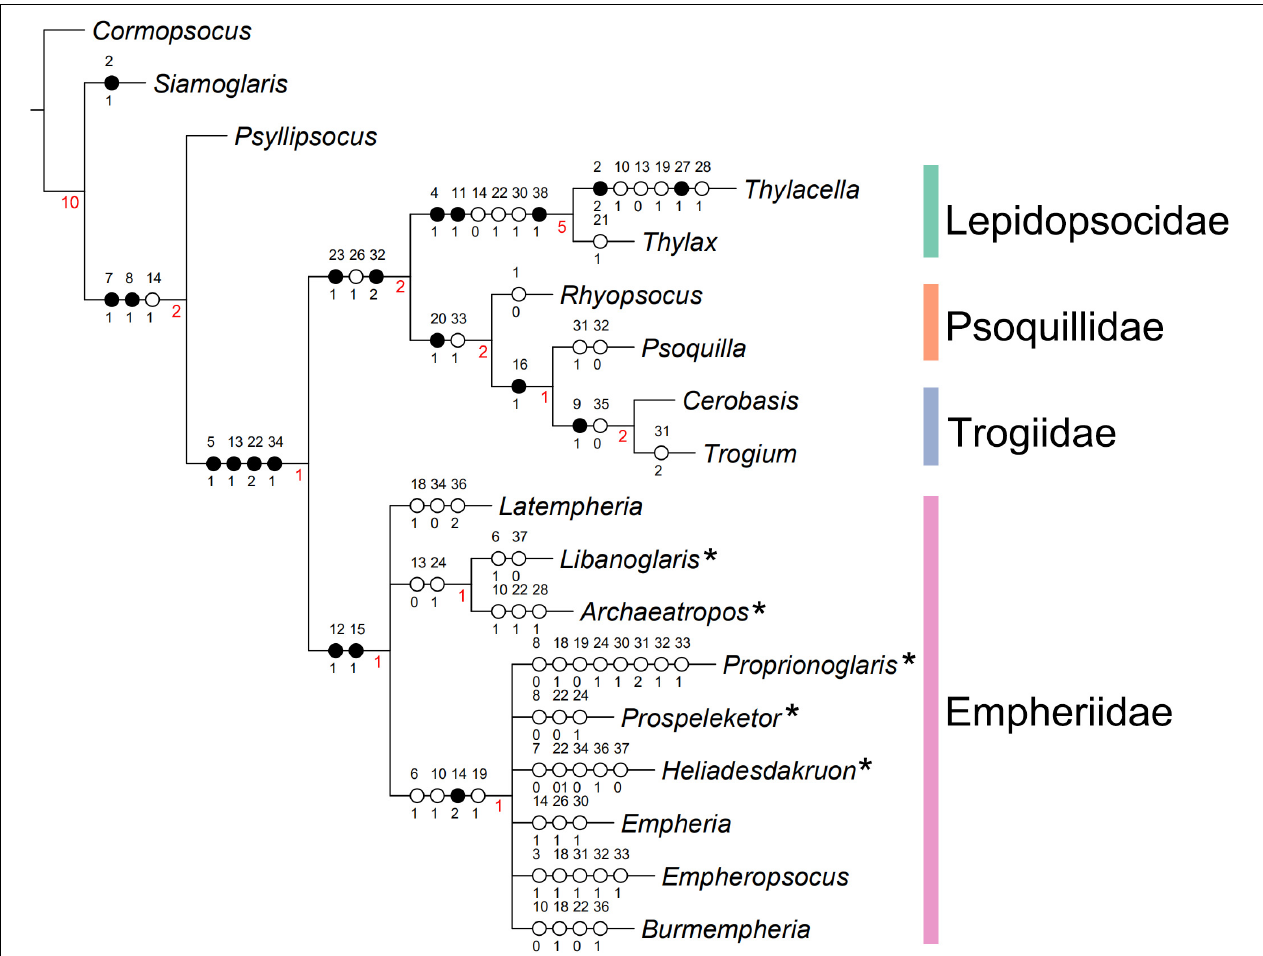
FIGURE 1 | Strict consensus tree of the most parsimonious tree. Phylogeny of Atropetae based on 18 species and 38 characters, with characters being non-additive, under equal weighting. Analyzed with WINCLADA v1.00.08 with NONA script (length = 93, CI = 0.47, RI = 0.54). * Represents the genus originally placed in